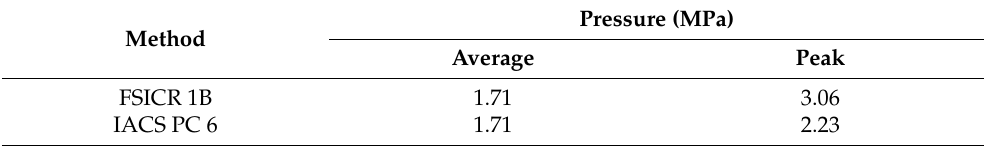
Figure 5. Ice thickness distribution in Lake Mälaren, Sweden between 1983–2017 [39]. Table 4. Pressure due to ice on the hull as calculated by different rules.